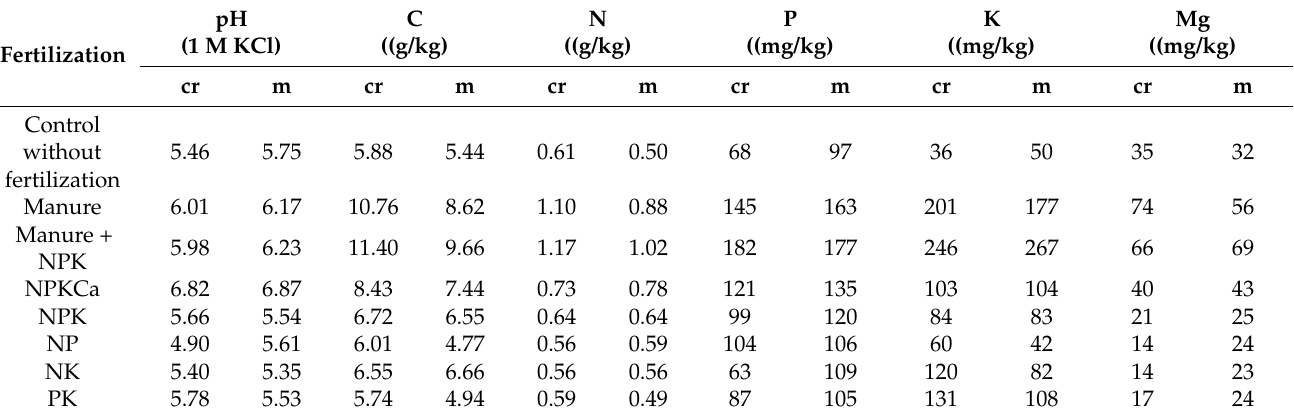
Table 6. Chemical properties of the soil (0–25 cm).